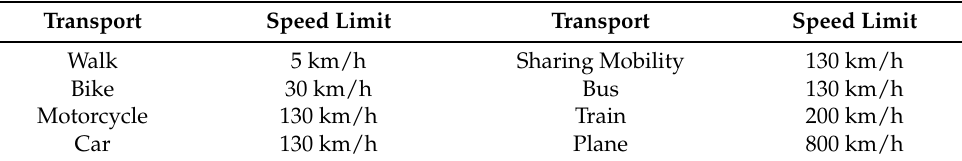
Table 1. Speed limits for our